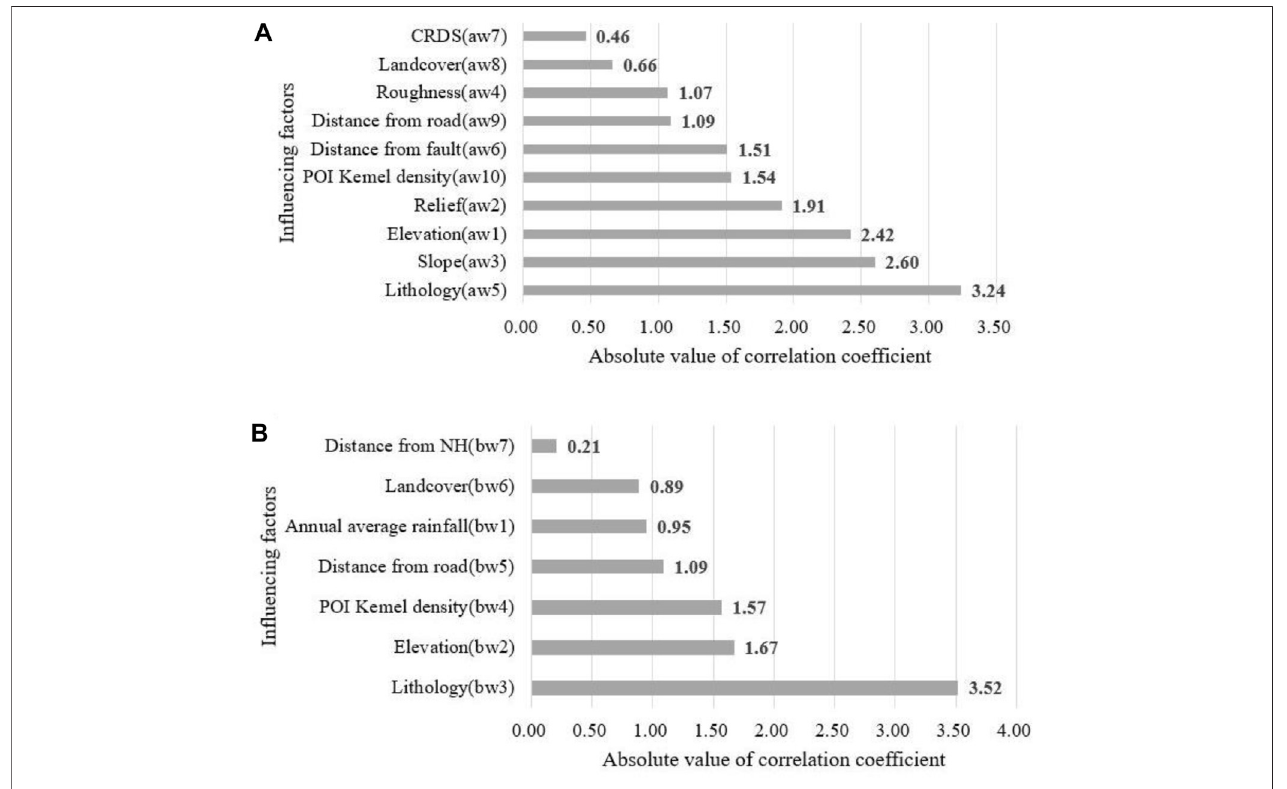
FIGURE 8 | Ranking chart of the absolute value of the correlation coef fi cient of conditioning factors: (A) LR ao model; (B) LR bo model.